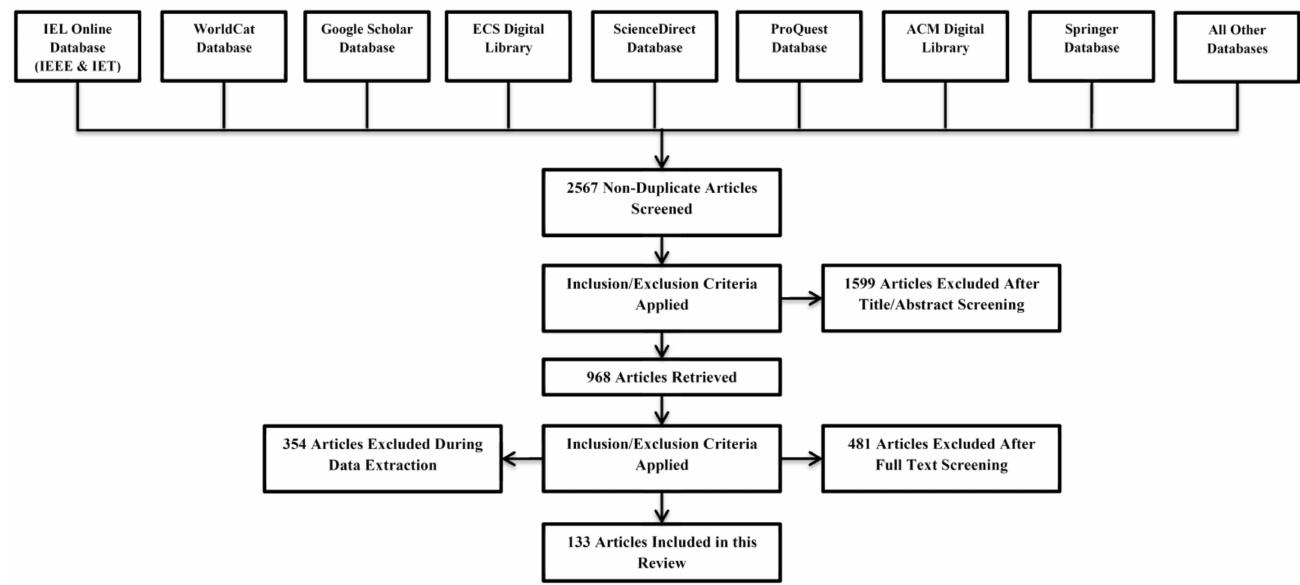
Figure 2. Prisma flow diagram for the selection process of the research articles used in this